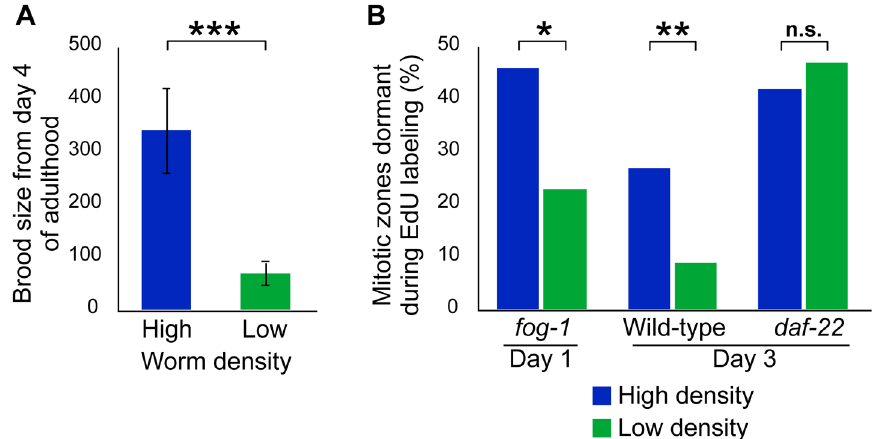
Fig 8. Population density influences intermittent cycling in a dauer pheromone dependent fashion. (A) Brood size of fog-1 females that had been kept at low or high density, and then mated at day 4 of adulthood (for statistical tests see S7A Table). Error bars represent 83% confidence intervals. Asterisks indicate significance of Wilcoxon rank sum test p ‑ value. (B) The percentage of mitotic zones that were in the